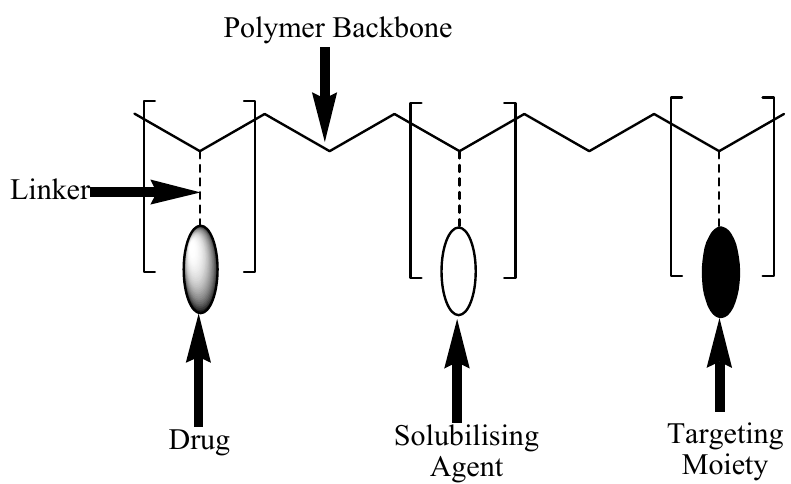
Figure 5. Schematic Diagram of polymer-drug conjugates.